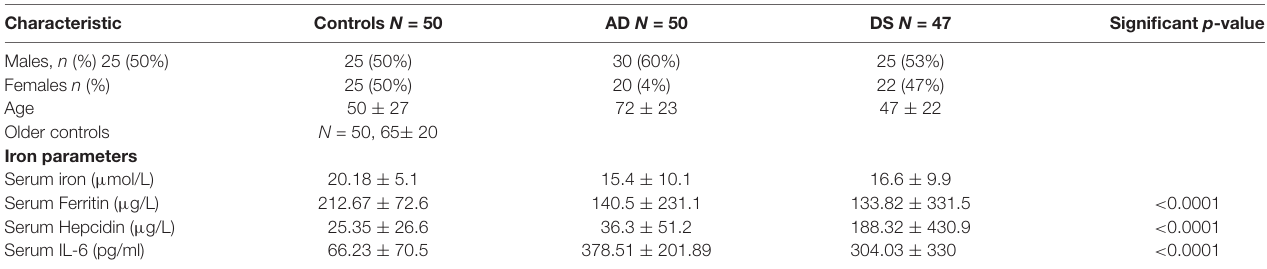
TABLE 2 | Characteristics of AD, DS and age matched control study population used to measure serum iron, ferritin, hepcidin, and IL-6. Characteristic Controls N =